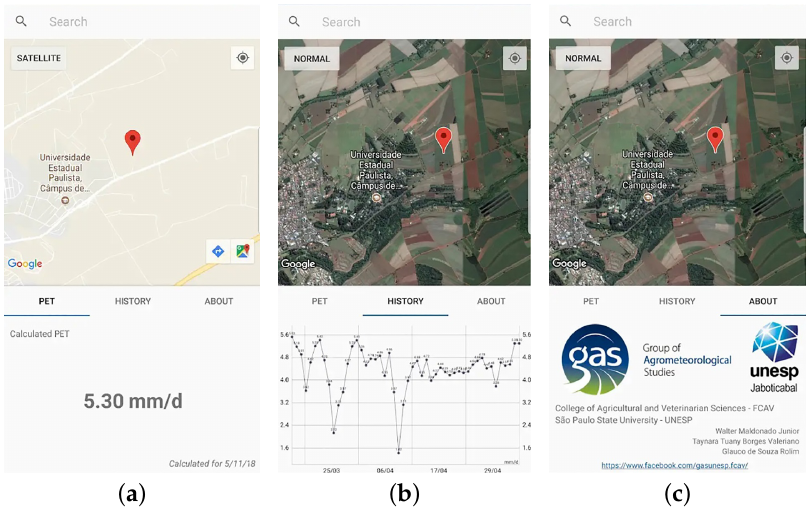
Figure 19. EVAPO: ( a ) “PET” tab with value obtained; ( b ) “History” tab with a time series of 50 past values of PET; ( c ) “About” tab with information about